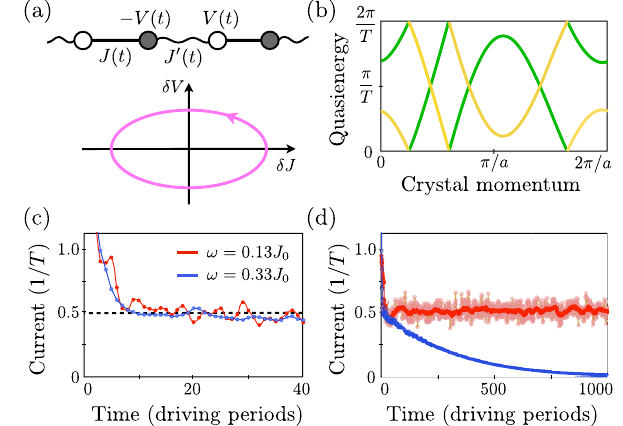
FIG. 1. Establishing the universal chiral quasi-steady state in a one-dimensional periodically driven system. (a) Tight binding model [see Eq. (1)]. The dimerized hopping amplitudes and on- site potentials are changed adiabatically as depicted by the magenta curve. The origin δ J ¼ δ V ¼ 0 is a degeneracy point. (b) The Floquet spectrum for ω ¼ 0 . 2 J 0 and λ ¼ 1 [see text below Eq. (1)]. The right-moving (left-moving) Floquet band is colored green (yellow). (c) The period-averaged current vs time obtained from a numerical simulation of a system of length L ¼ 16 unit cells with N ¼ 8 particles, for two different driving frequencies (see legend). After a few driving periods, the system reaches a quasi-steady state featuring a current J ≈ ρ =T , where ρ ¼ N=L is the density of particles. (d) At low frequency ( ω ¼ 0 . 13 J 0 , red), the chiral quasi-steady state persists for thousands of periods without noticeable decay. Interband scatter- ing leads to a decay of the current with a rate that falls exponentially with 1 = ω (visible here for ω ¼ 0 . 33 J 0 , blue). In panels (c) and (d), λ ¼ 0 . 66 , U ¼ 2 J 0